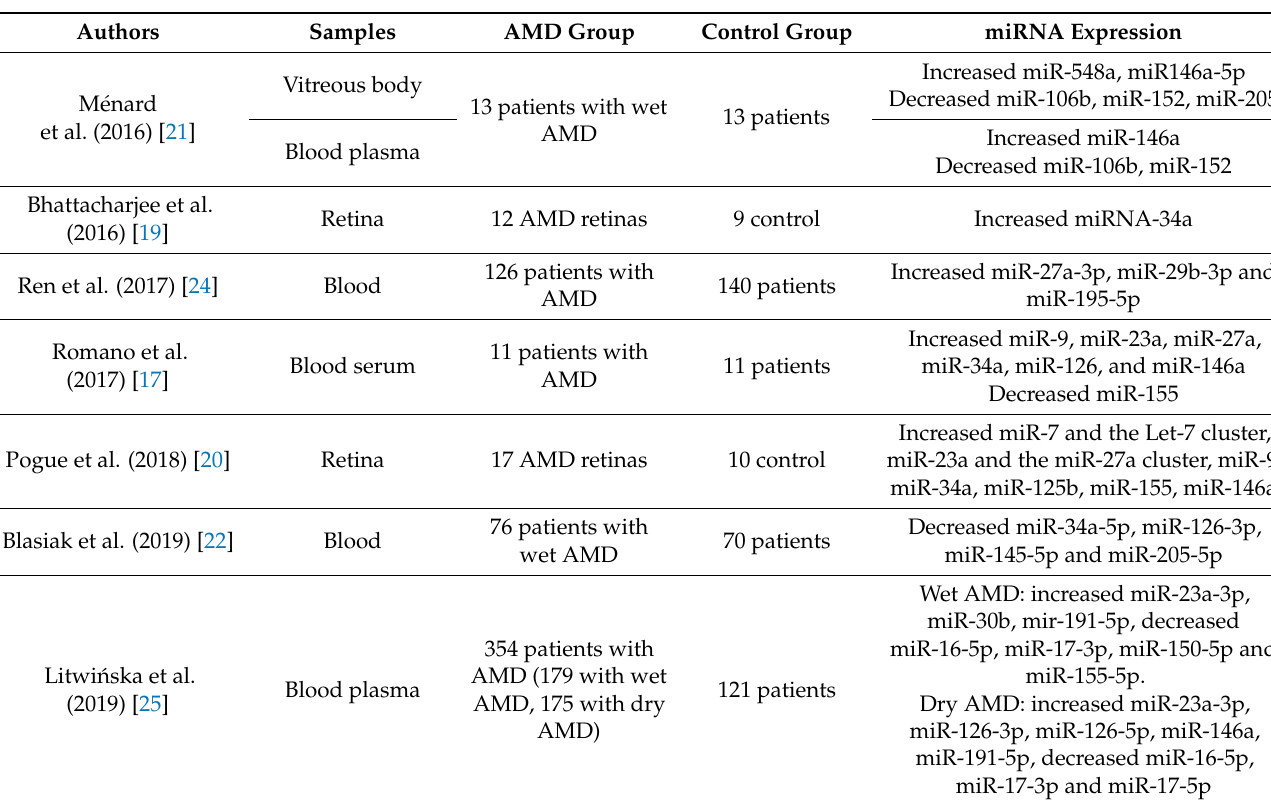
Table 1. Summary of miRNAs found in